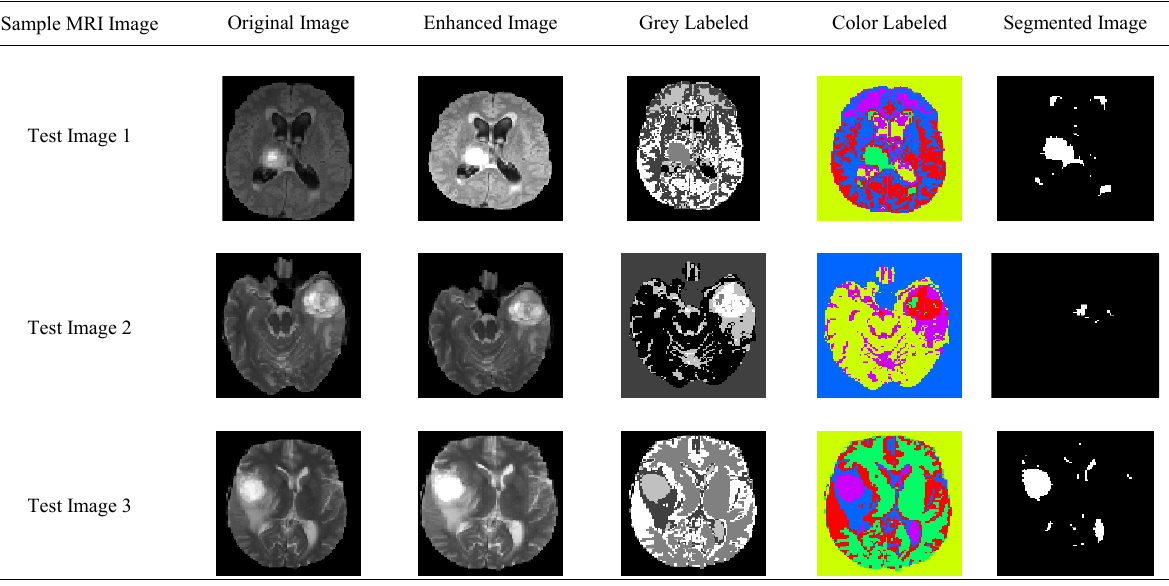
Table 1. Image Segmentation using k-means